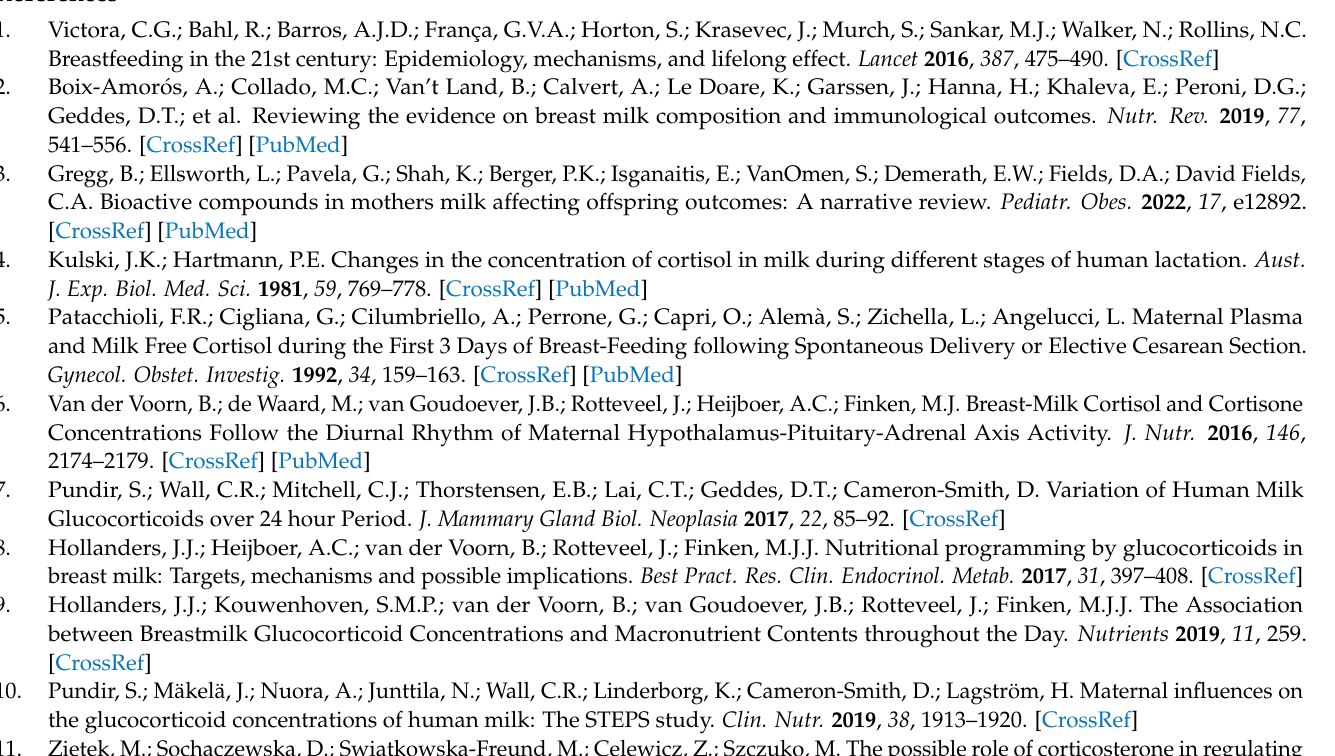
milk collection. Table S2: Partial correlations between the breastmilk cortisol (log) and breastmilk fatty acid profile (log) adjusted for season of breastmilk